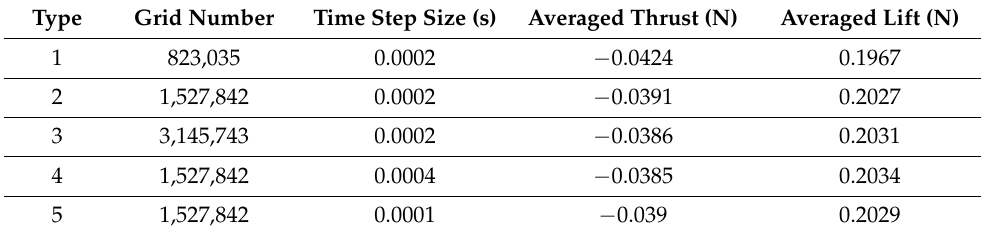
Table 4. Simulation conditions and research objectives.